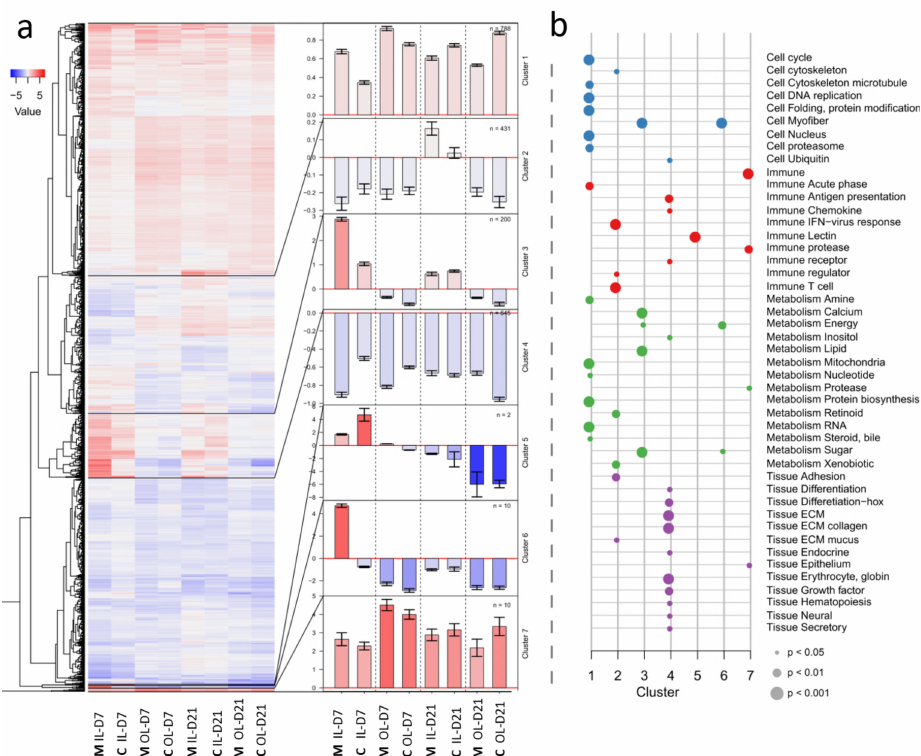
Figure 4. Transcriptomic responses to lice and diets at 7 and 21 dpc ( a ) Heatmap of mean log2-ER with dendrogram for the genes. One line represents one gene, and each column is a study group. Blue is for downregulation and red for upregulation. The heatmap was cut into seven clusters. The bar plots in the middle show the mean values of the respective clusters with +/ − SEM error bars. Black lines in the heatmap indicate where clusters begin and end. The numbers of genes per cluster are shown. ( b ) The enrichment analysis of functional categories of STARS (Krasnov et al., 2011a) was performed within the clusters. Each vertical line represents one cluster. Dots on these lines indicate a significant enrichment of the categories shown on the right end (Fisher test p -value < 0.05). Colors indicate categories related to Cell structures and processes, Immune system, Metabolism and Tissue structure and development. Abbreviations: OL, IL—outer and inner layers, M, C—diets, D—days post-challenge